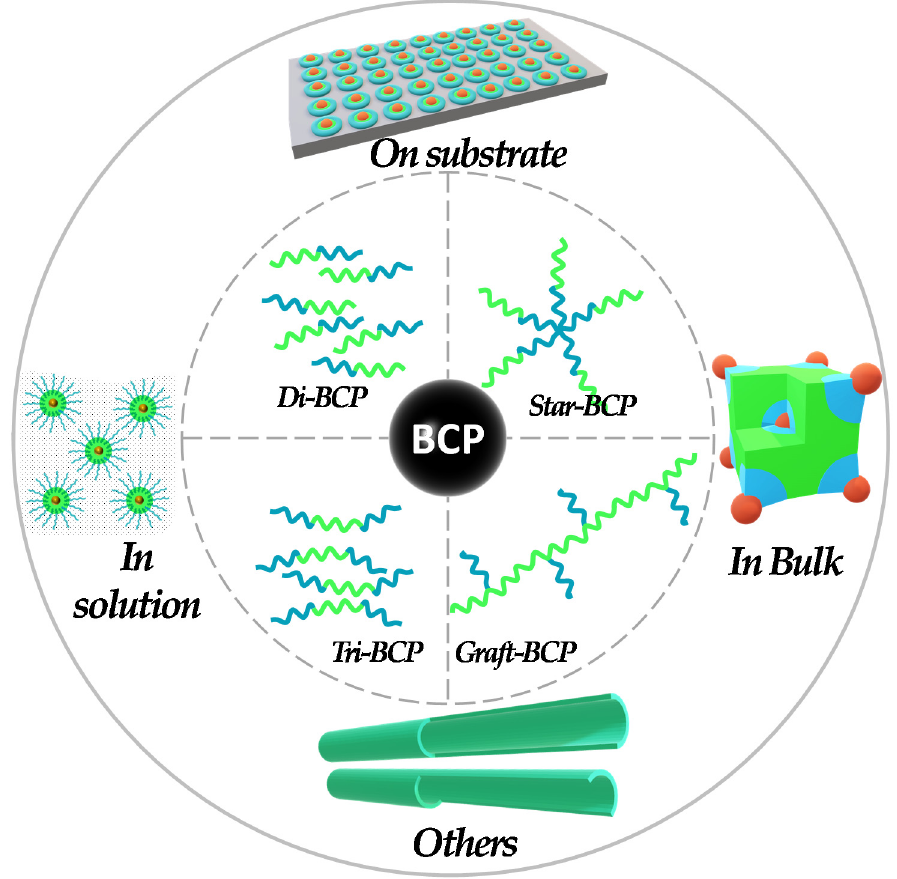
Figure 1. BCP template-based approaches used for the fabrication of (nano-)catalysts.